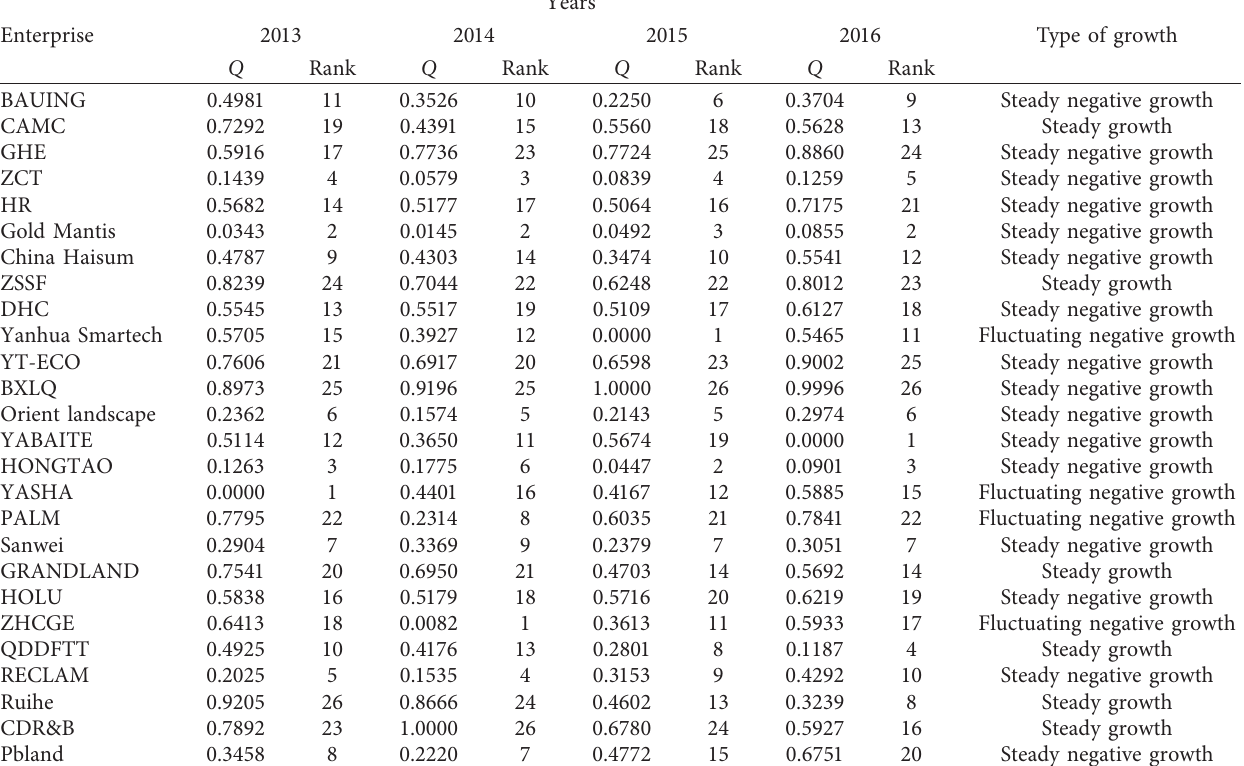
Table 4: Enterprise Q value ranking (2013–2016).